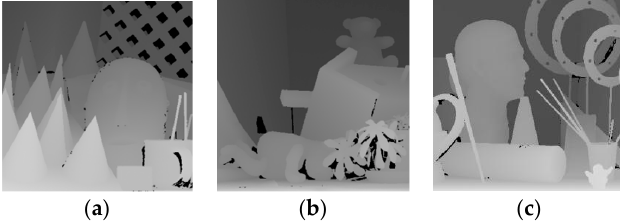
Figure 2. Experimental test images (1): ( a ) represents the Mask depth image; ( b ) represents the Teddy depth image; ( c ) represents the Art depth image. In Experiment (2), we obtained degraded depth images by adding artificial text, as shown in Figure 3. The original images were the images repaired with the GSR algorithm in Experiment (1).